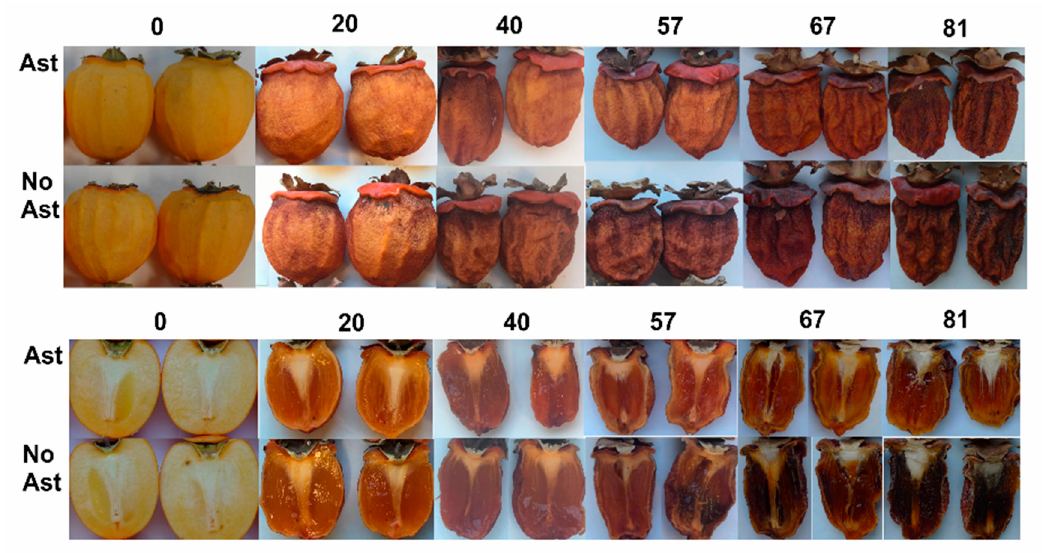
Figure 2. Images of the astringent and non-astringent persimmon cv. “Rojo Brillante” during the drying process.